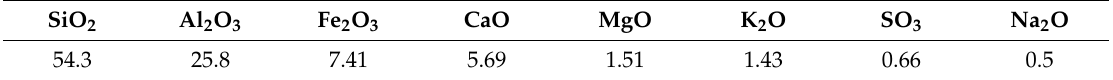
Table 1. Chemical composition of fly ash (unit: